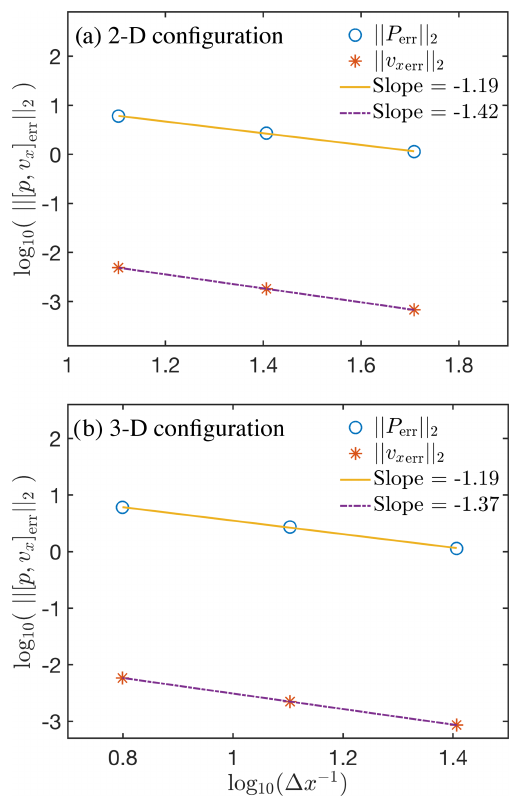
Figure 15. Evolution of velocity and pressure truncation errors (L2 norm) upon grid refinement for (a) the 2-D configuration and (b) the 3-D configuration of Experiment